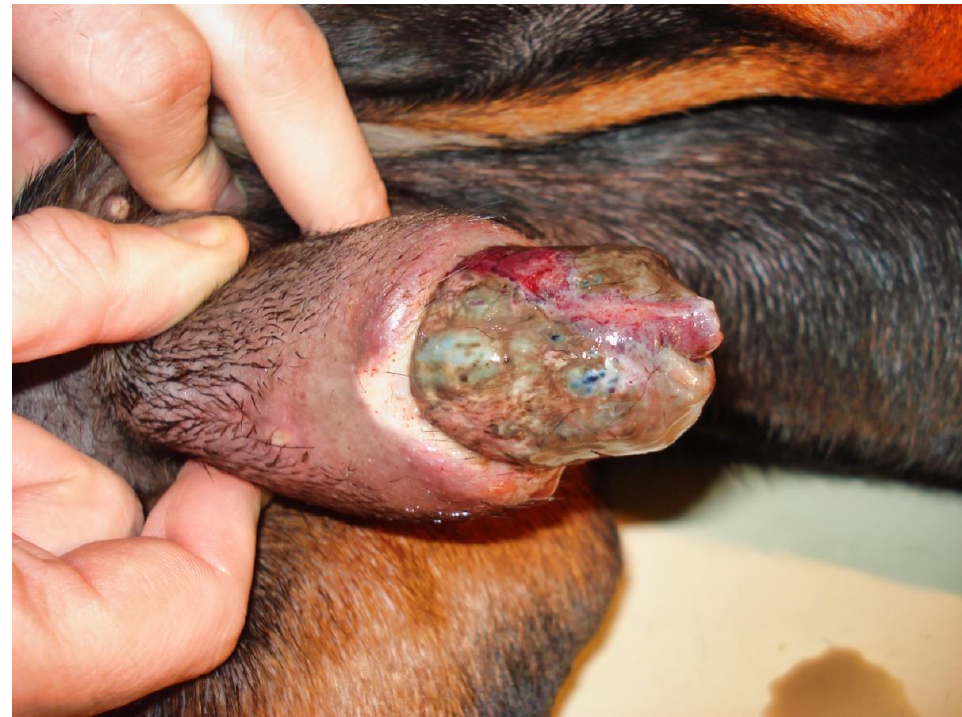
Figure 2. Partial exteriorization of the penis revealing a markedly engorged, rigid penis, dark purple in color with a darker area.